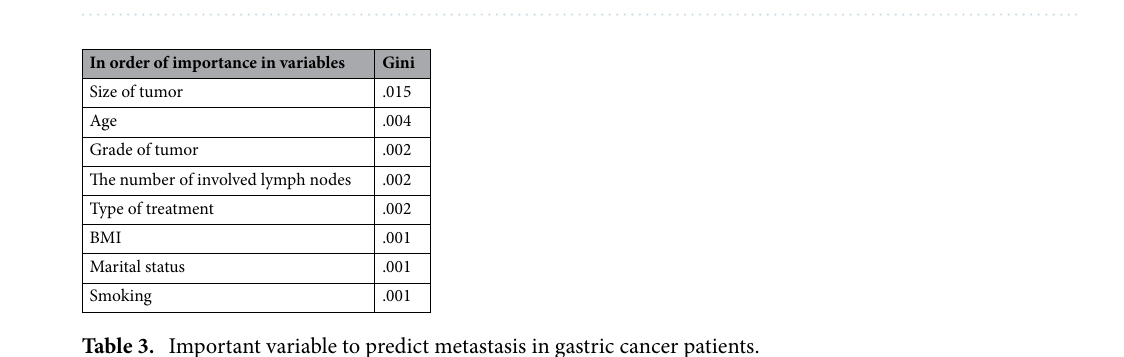
Figure 7. Visualization of decision tree model; The first part is the root node of the tree. To predict the outcome, start from the root node (PT variable) and then go to the next intermediate nodes and the edges show which subsets are visited. Once one reach the final subsets (named leaf node), the predicted outcome is assessed by leaf node.